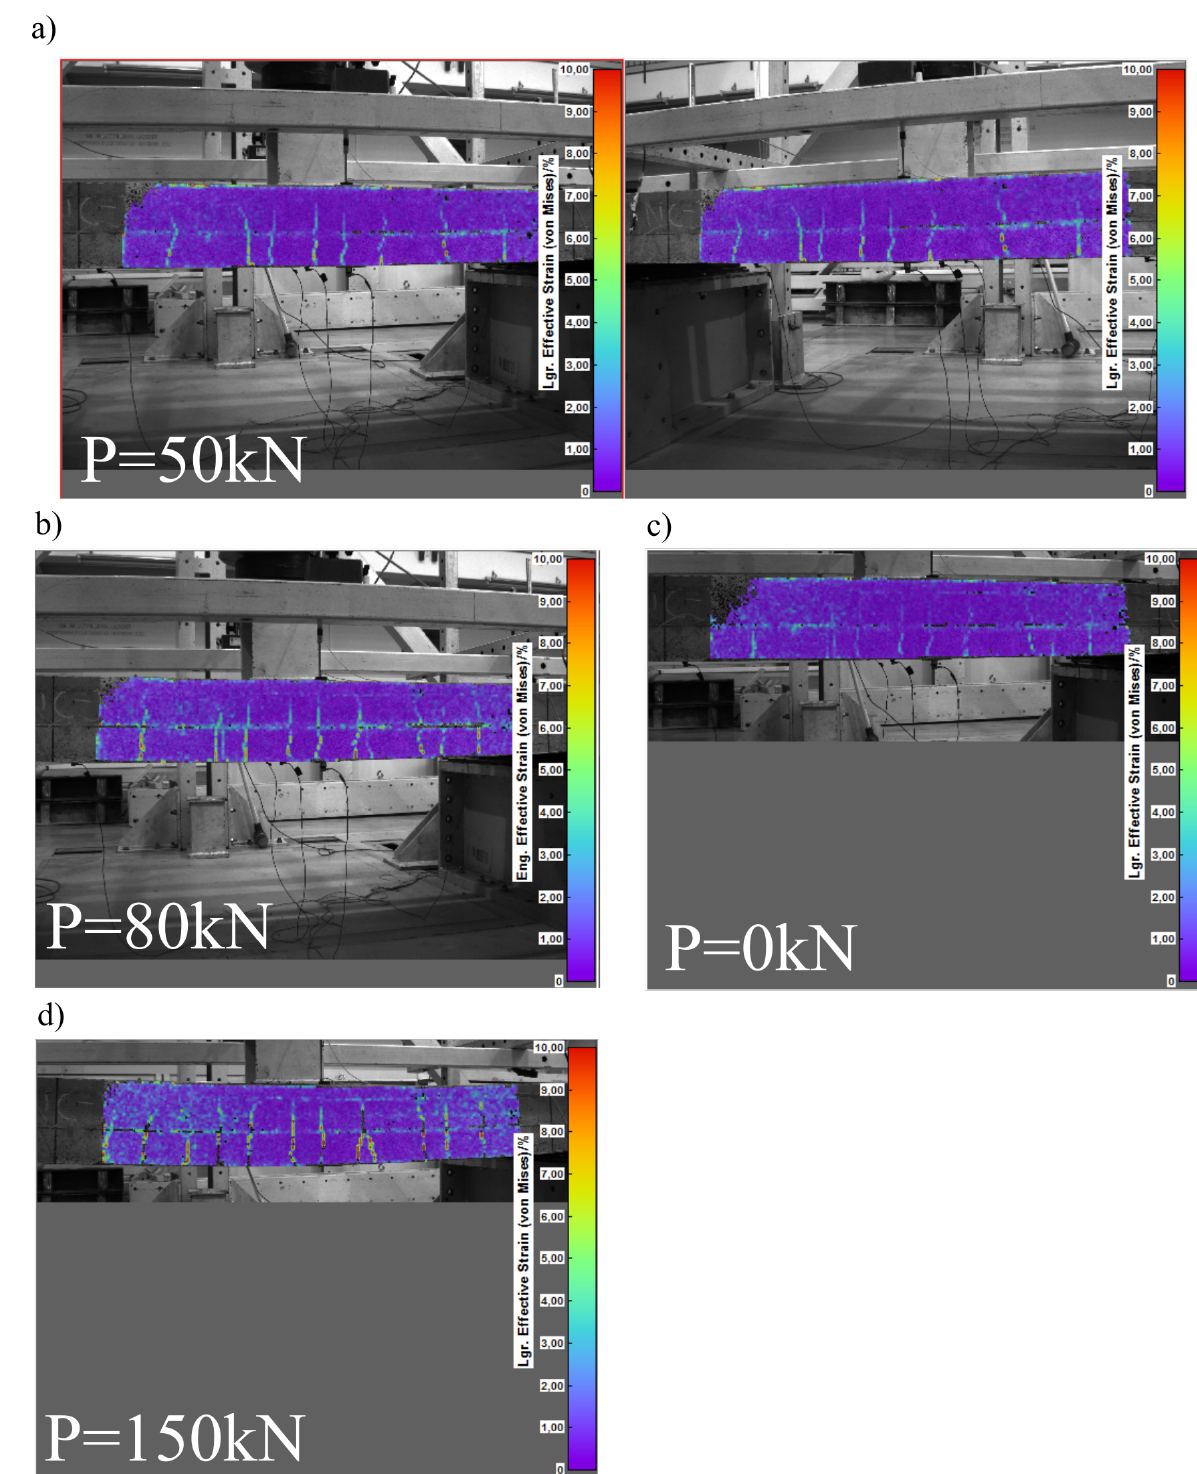
Figure 5. Lagrange effective strain distribution obtained with DIC application under different loading levels of the slab. In all figures, the same color scale is used (0–10%); ( a ) pictures registered by both cameras; ( b – d ) picture registered by the left